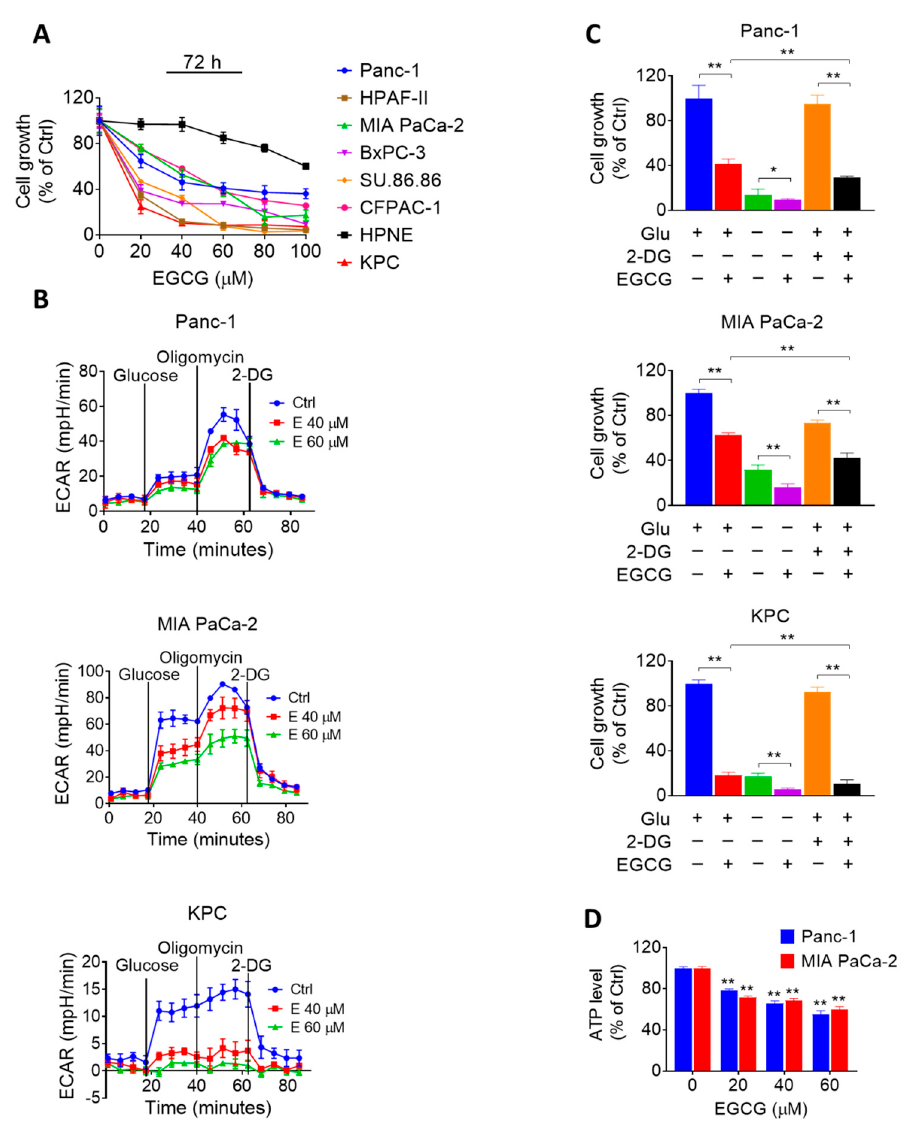
Figure 1. Epigallocatechin-3-gallate (EGCG) inhibits pancreatic cancer cell growth through glycolysis suppression. ( A ) EGCG inhibits human pancreatic cancer cell growth in a concentration-dependent manner. Cell growth was determined in Panc-1, MIA PaCa-2, HPAF-II, BxPC-3, SU-86.86, CFPAC-1, and KPC pancreatic cancer cells, and in the human pancreatic normal epithelial (HPNE) cells after treatment with increasing EGCG concentrations for 72 h. Results are expressed as a percentage of control. ( B ) EGCG suppresses glycolysis capacity in Panc-1, MIA PaCa-2, and KPC cells after 24 h. Glucose (25 mM), Oligomycin (1 µ M) and 2-Deoxy-D-glucose (2-DG) (75 mM) were injected and the extracellular acidification rate (ECAR) of live cells was monitored during the experimental period. Results are presented as the mean ± SD of ECAR. ( C ) Cell growth was measured in Panc-1, MIA PaCa-2, and KPC cells treated with or without EGCG (40 µ M) under glucose deprivation or 2-DG (10 mM) treatment condition. Results are expressed as a percentage of control. * p < 0.05, ** p < 0.01 vs. control. ( D ) EGCG reduced ATP levels in Panc-1 and MIA PaCa-2 cells after 24 h. Results are expressed as a percentage of control. * p < 0.05, ** p < 0.01 vs. control.